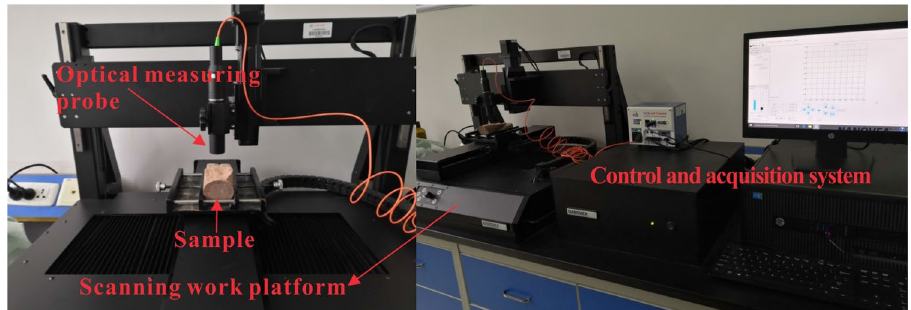
Figure 3. ST500 three-dimensional non-contact surface profiler.